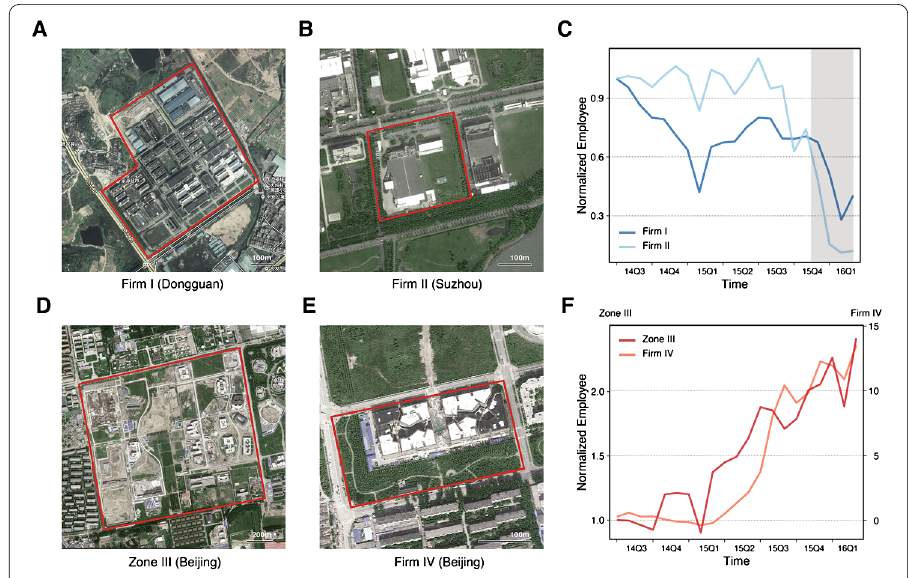
Figure 2 Measuring employment changes at the company/zone level. We study four typical cases, Firm I (A) and Firm II (B) announced mass layoffs, and Zone III (D) and Firm IV (E) experienced rapid growth. The normalized employee data are shown in (C) and (F) . The closing times for Firms I and II are marked by the grey bar in (C) . Remote sensing images were derived from Baidu